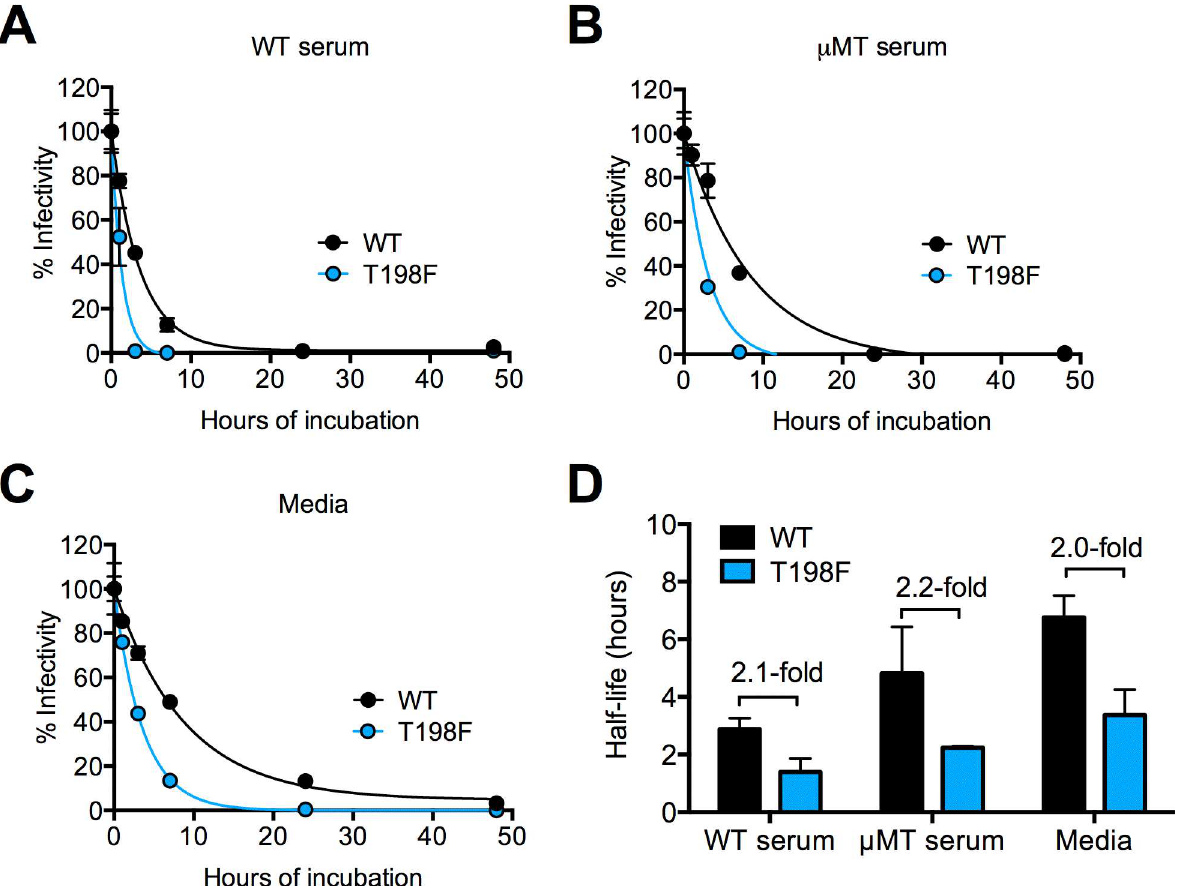
Fig 9. Effect of natural antibodies on WNV intrinsic decay. Representative intrinsicdecay curves of fully infectiousWT and T198F viruses in serum obtained from (A) na ï veWT C57BL/6Jmice, (B) na ï ve μ MT C57BL/6Jmice, and (C) media. Experiments were performed as describedin Fig 4A . Error bars indicatethe SEM from triplicate infections. (D) Average half-life values of WT and T198F viruses followingprolongedincubation in serum obtainedfrom na ï veWT mice, na ï ve μ MT mice, or media obtained from two independent experiments performed using independentserum samples and virus preparations. Error bars indicatethe SEM. Fold-differences in half- life betweenWT and T198F WNV in each incubation conditionare indicated.